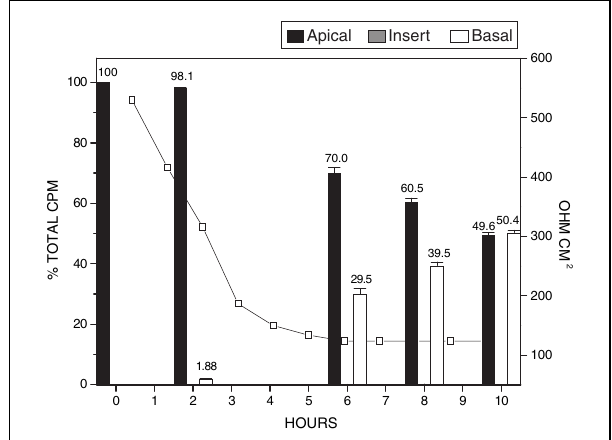
Figure 5) Radioactive count distribution for inserts treated with 125 I labelled toxin B and unlabelled toxin A. Inserts were inoculated with 250 µL of 125 I labelled toxin B (0.250 µg/mL) and 250 µL of unlabelled toxin A. Samples from apical, basal and insert were tested for per cent of the total input counts per minute (cpm). The figure rep- resents the average of three separate experiments. The electrical resist- ance measurements indicate the level of tight junction integrity. The total amount of radioactivity inoculated onto the insert in the form of radiolabelled toxin B was 7.0 × 10 3 cpm